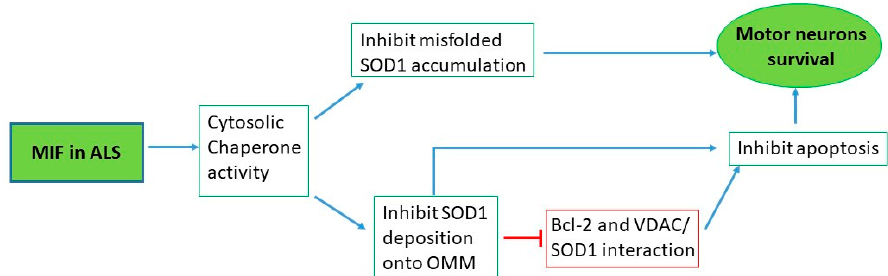
Figure 1. MIF in ALS. Preclinical studies on MIF in ALS which show the results obtained in vitro and in vivo and the correlation between MIF chaperone activity and its protective e ff ect against mutant SOD1 toxicity in motor neurons. MIF also inhibits the activation of pro-apoptotic mitochondrial pathway, blocking misfolded SOD1 interactions with outer mitochondrial membrane proteins, such as Bcl-2 and VDAC